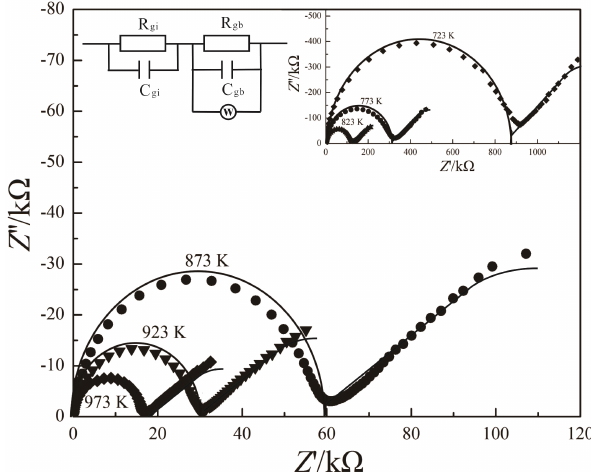
Figure 2. Nyquist plot of the complex impedance of quartz andesite under conditions of 1.0GPa and